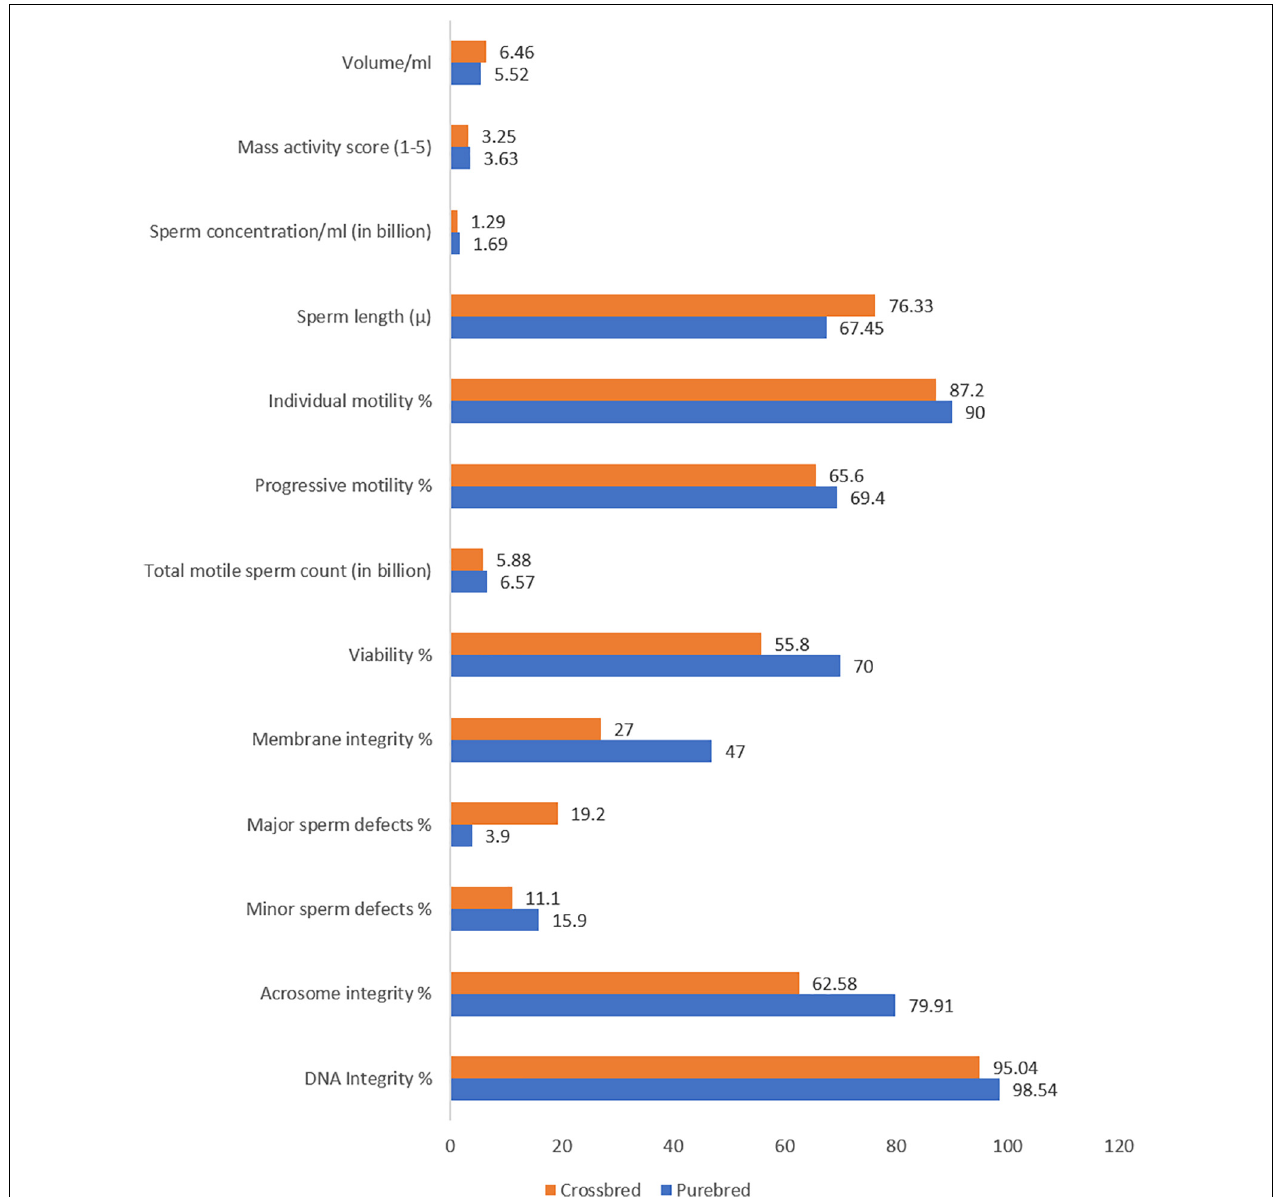
FIGURE 2 | Semenological differences between purebred and crossbred bulls (based on data from Singh et al., 2000; Sarder, 2003; Brito et al., 2004; Mukhopadhyay et al., 2010; Zubair et al., 2013; Kumar et al., 2015; Khan et al., 2018; Isnaini et al., 2019; Chung et al.,